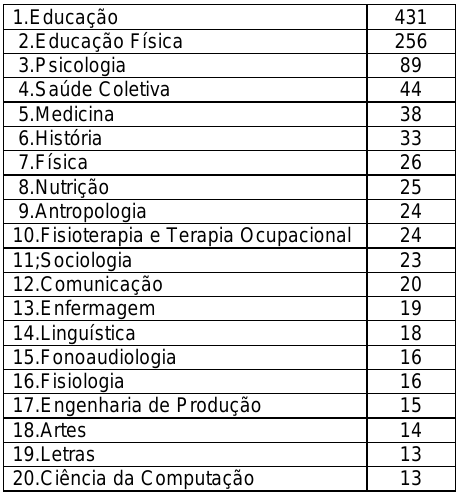
Tabela 2 . Grupos e áreas de conhecimento (vinte primeiros). Fonte: Portal da Inovação. Acesso em: